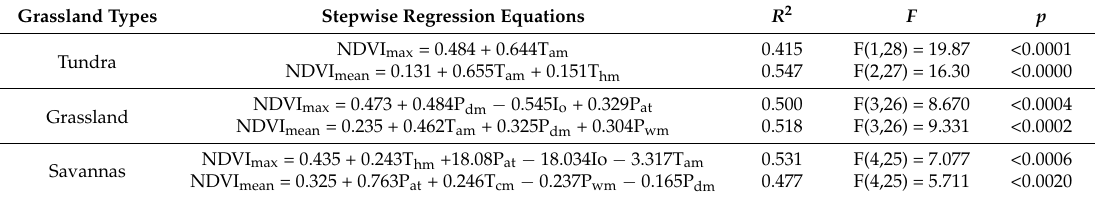
Table 3. Stepwise multiple regression between NDVI and bioclimatic factors of different OGFD ecosystems from 1982 to 2011. The NDVI max is the annual maximum values of NDVI; NDVI mean is the annual mean values of NDVI; P at is annual total precipitation (mm); P wm is the precipitation of the wettest month (mm); P dm is the precipitation of the driest month (mm); T am is annual mean temperature ( ˝ C); T hm is the mean temperature of the hottest month ( ˝ C); T cm is the mean temperature of the coldest month ( ˝ C); and I o is the ombrothermic